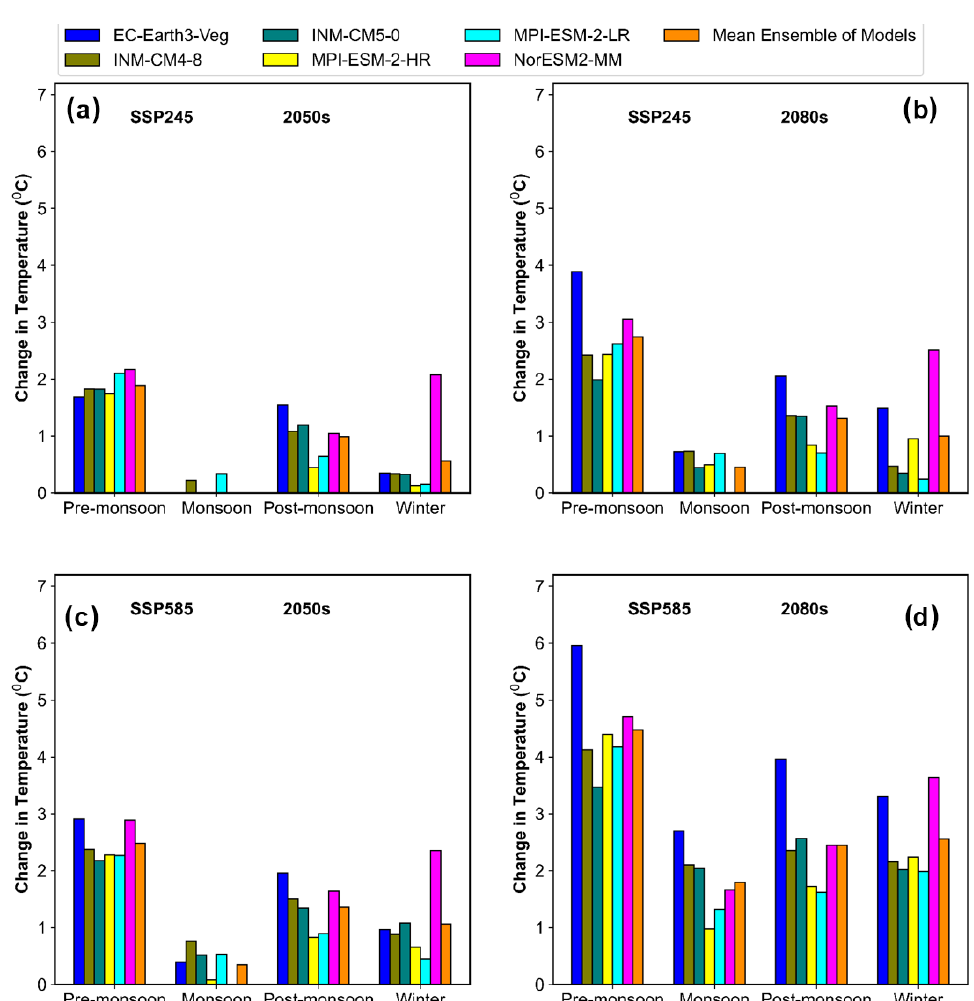
Figure 14. Projected change in the mean seasonal maximum temperature ( T max ) in the sub-basin using different CMIP6 GCMs under the SSP245 and SSP585 scenarios in the (a, c) 2050s and (b, d)